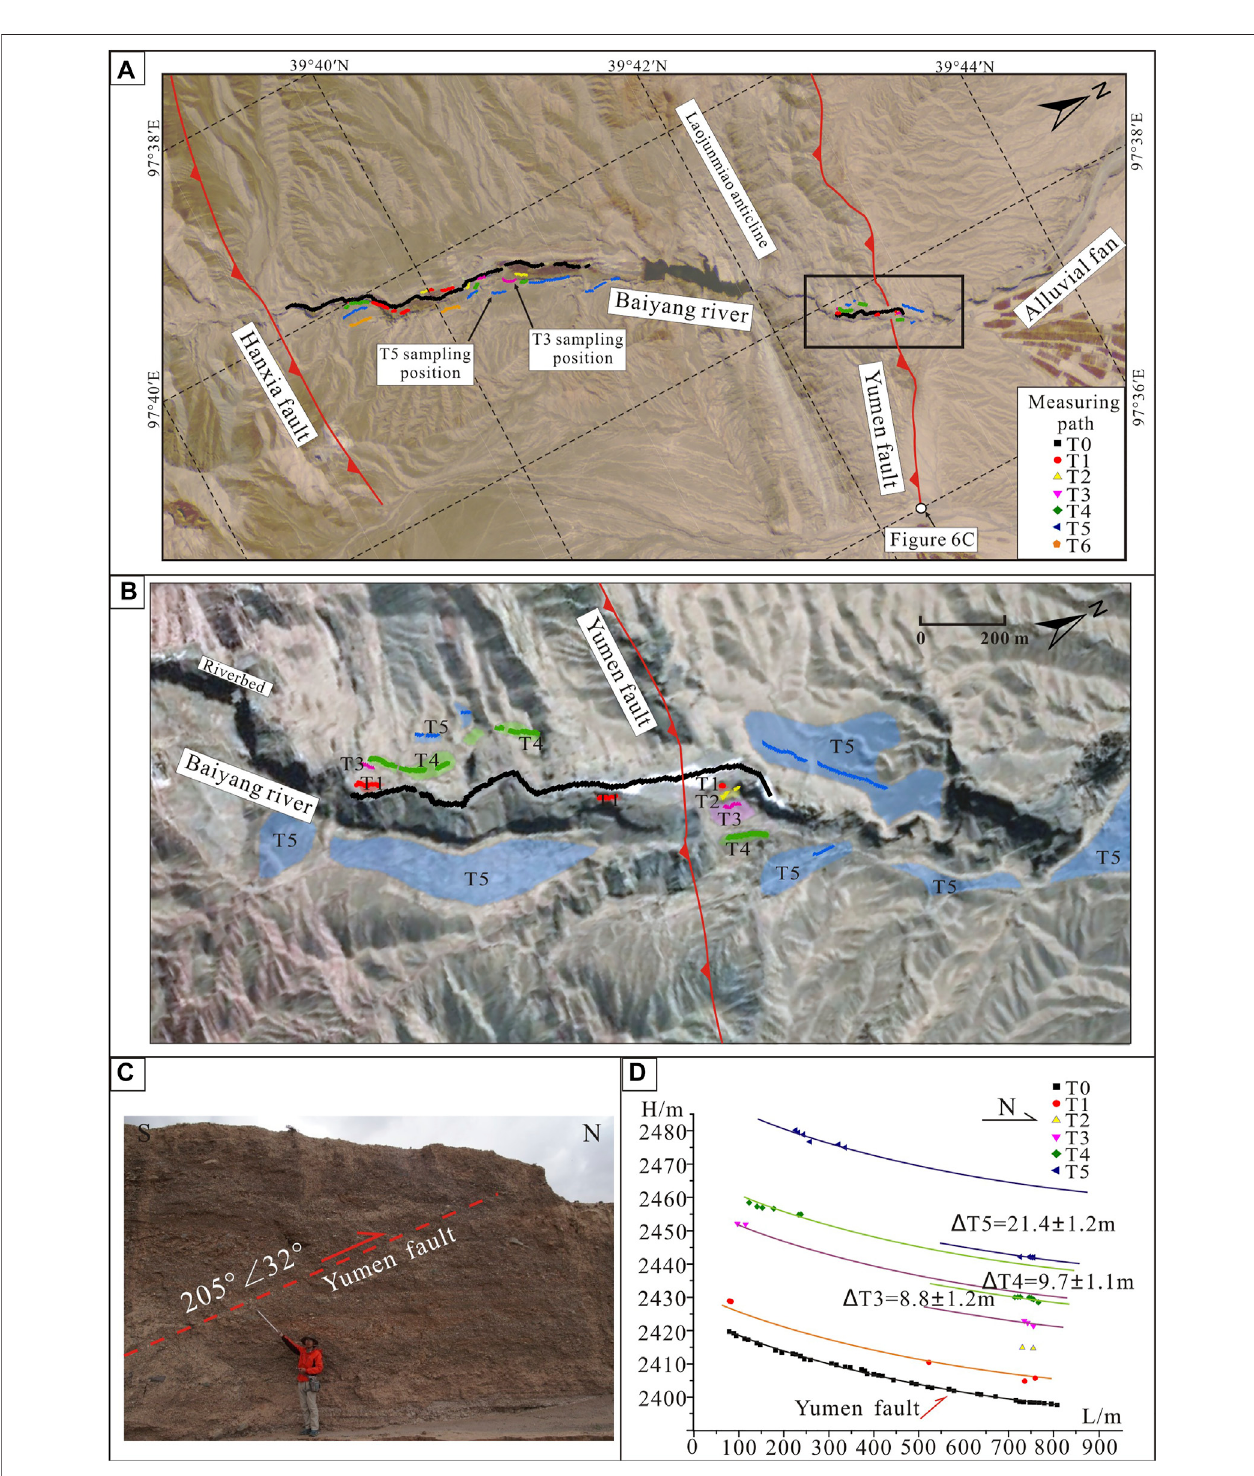
FIGURE6|(A) Satelliteimage oftheBaiyangriverinthenorthern Qilian Shanfront. Thered lines represent thefault traces.Thecolored dotsdenote themeasuring paths of terraces. The 10 Be sampling positions of T3 and T5 terraces have been exhibited. The image range is shown in the black rectangle of Figure 8A . (B) Satellite image of the Baiyang river near the Yumen fault showing the terrace distribution. The image range is shown in the black rectangle of (A) . The colored dots denote the measuring paths of terraces. (C) The photograph of fault scarp of the Yumen fault in the alluvial fan. The location of photograph is shown in the (A) . (D) The longitudinal pro fi les of terraces (T1 – T5) and the modern riverbed (T0) of the Baiyang river near the Yumen fault. The measuring paths have been shown in the (B) (Chen and Koronovskii, 2020; revised).